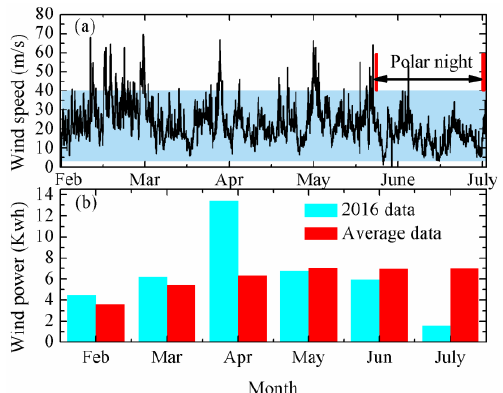
Figure 20. ( a ) Wind speed measured by the observing system, and ( b ) monthly wind power generated by the power system and calculated by the average data from 6 February 2017 to 9 July 2017, respectively. Area between the red lines is the polar night. The dark-blue area represents the available